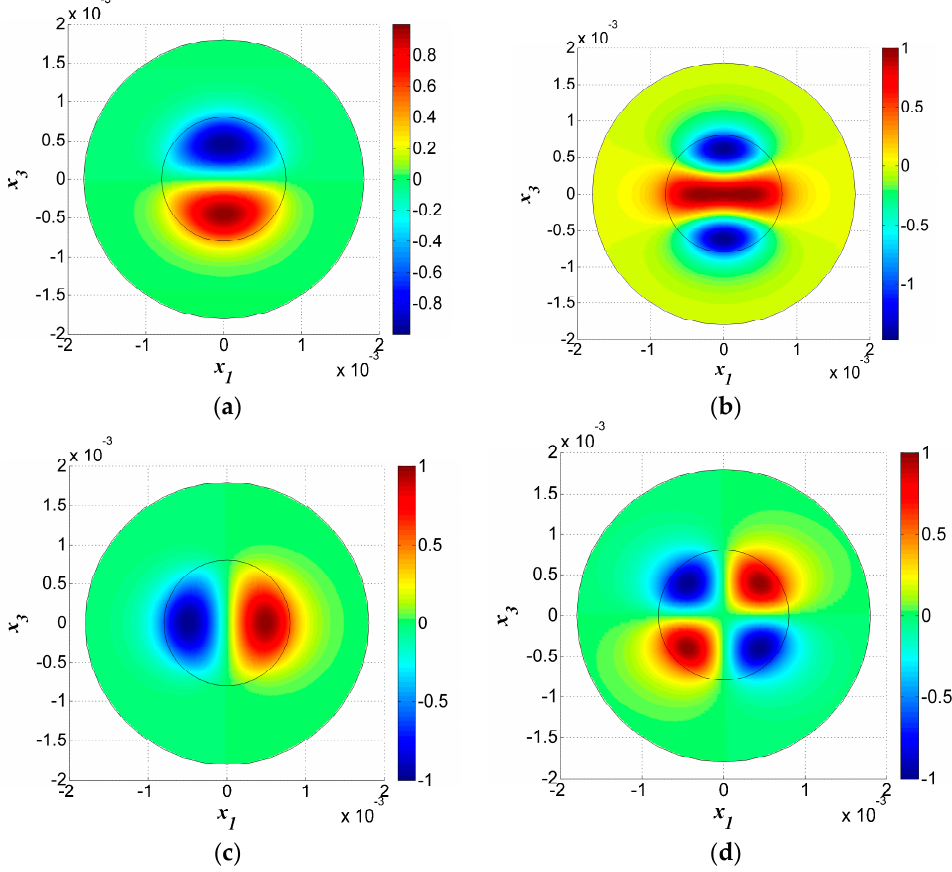
Figure 4. Thickness-shear modes for n = 1, R = 5%. ( a ) f = 1.606972 × 10 7 Hz; ( b ) f = 1.634720 × 10 7 Hz; ( c ) f = 1.614183 × 10 7 Hz; ( d ) f = 1.639936 × 10 7 Hz.